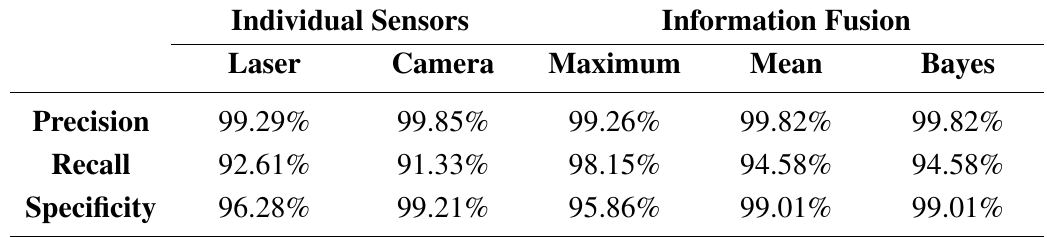
Table 7. Gymnasium experiment results. Comparison of the fixed ( a ) and the proposed adaptive ( b ) projection methods. The performance of using each sensor individually is also compared with three different information fusion techniques. The data sets used for these results are shown in Table